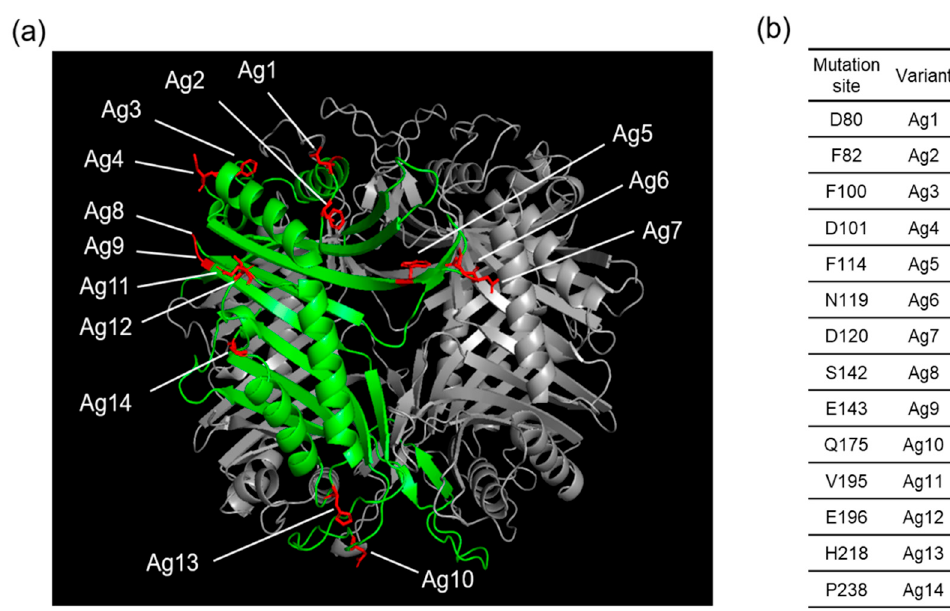
Figure 1. ( a ) Crystal structure of AgUox (PDB code: 2YZE) showing the selected sites for frTet incorporation. ( b ) The frTet incorporation sites and corresponding AgUox variants containing frTet are indicated in the table.